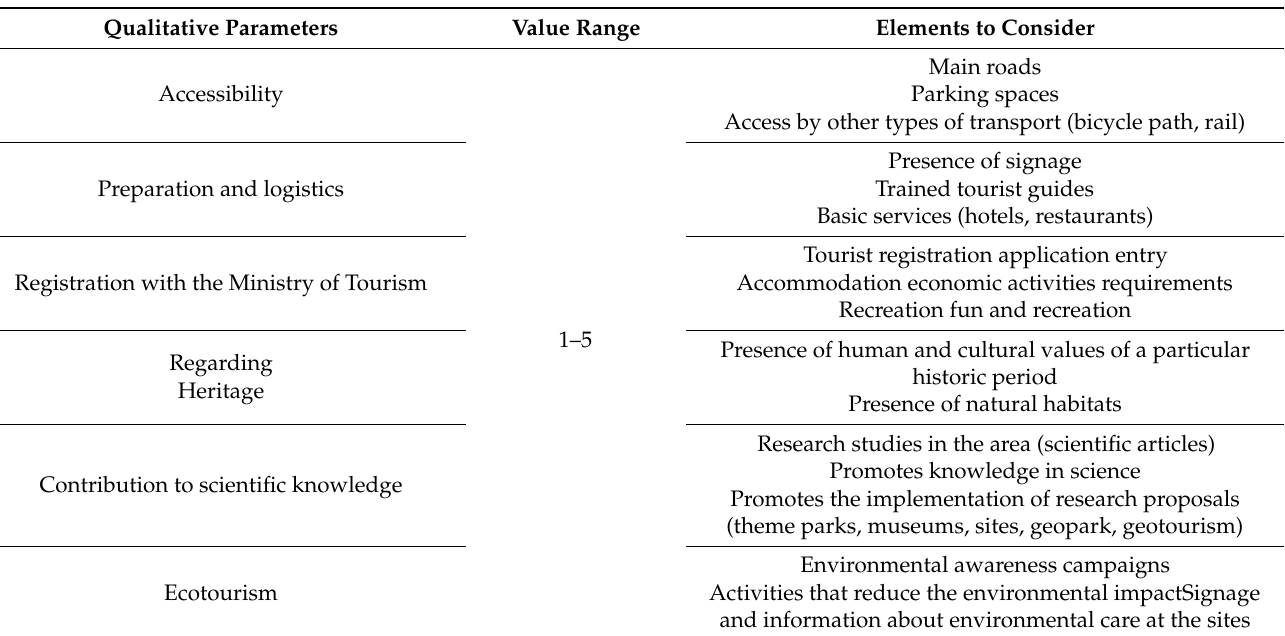
Table 1. Geotourism Routes Evaluation Matrix (GtRAM) for the sites that make up the geotourism and geomining routes in this